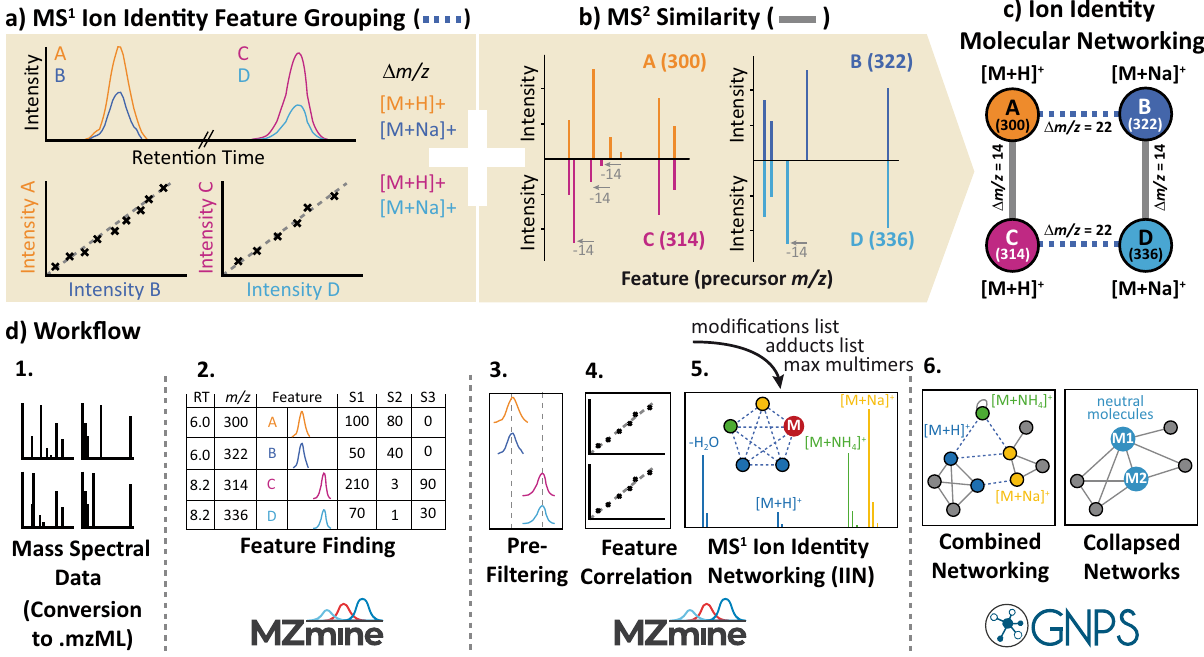
Fig. 1 The concept of ion identity molecular networking (IIMN). The work fl ow integrates a MS 1 feature grouping to connect different ion species of the same compound and b feature-based molecular networking to connect similar compound structures based on MS 2 spectral similarity to yield c combined networks. d highlights the data processing steps to create IIMN networks in MZmine and GNPS. After feature detection and alignment across multiple samples, features are grouped based on the correlation of their chromatographic feature shapes (intensity pro fi les) and other MS 1 characteristics. Subsequently, ion species of grouped features are identi fi ed with an ion identity library generated based on user input for included adducts, in-source modi fi cations, and a maximum multimer parameter. After uploading these results to the GNPS web server, the IIMN work fl ow generates combined networks and an alternative output with all IIN collapsed into single molecular nodes to reduce complexity and